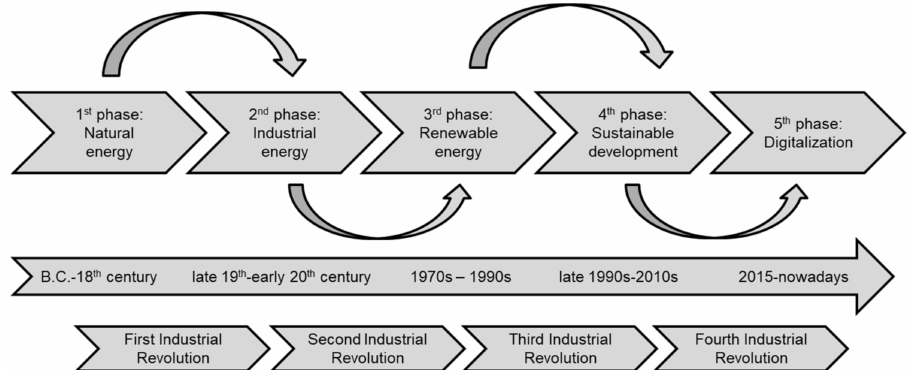
Figure 1. Development of the energy sector prior and beyond the first to the fourth Industrial Revolutions. Source: own